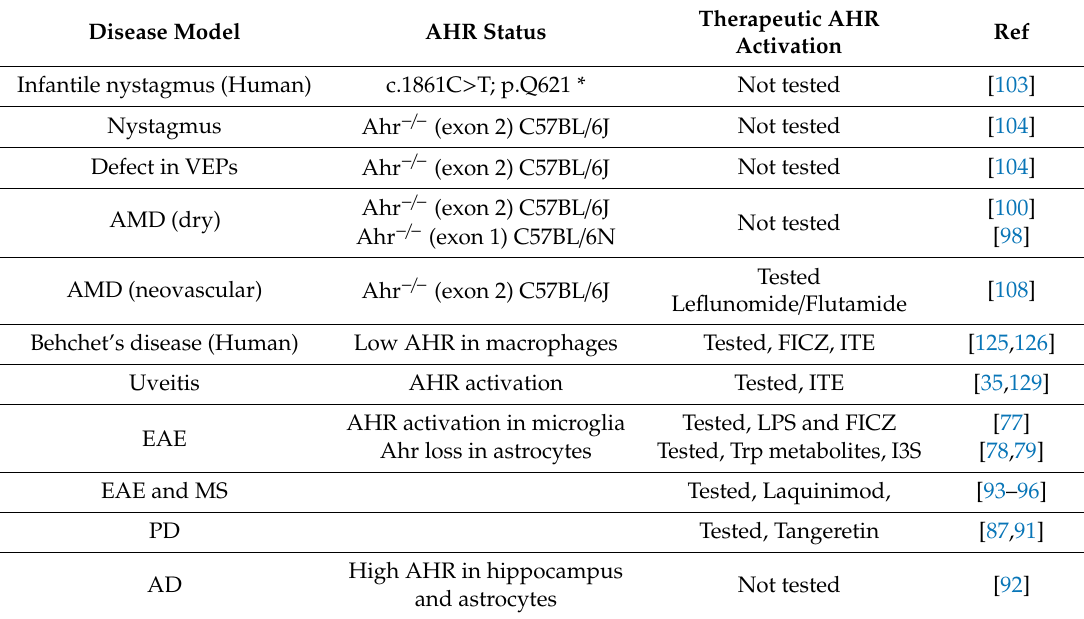
Table 2. The role of the AHR in retinal and neurodegenerative